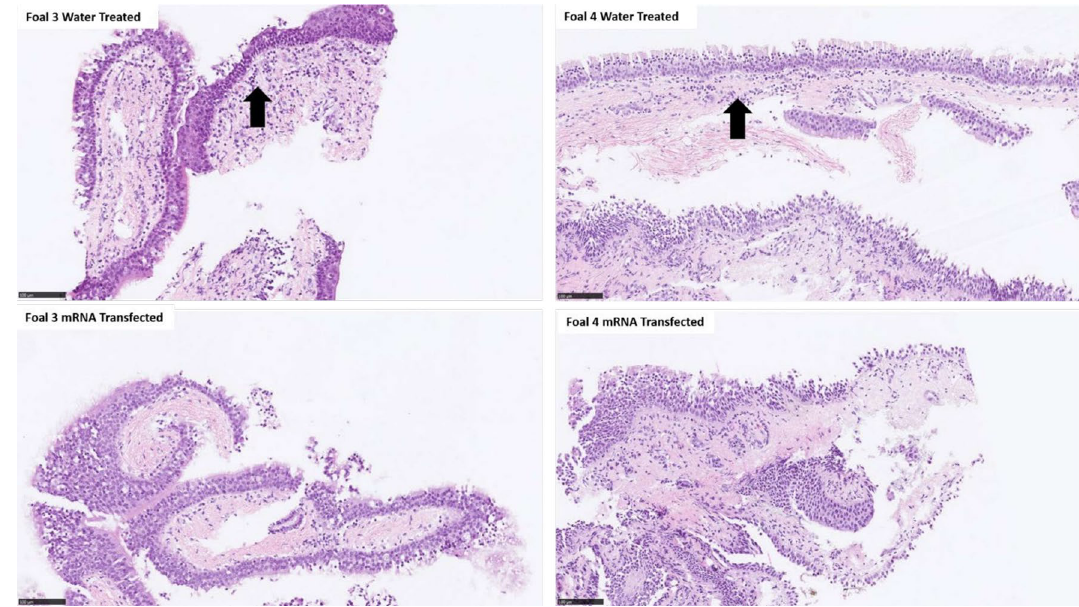
Figure 6. Transfection with eGFP did not result in microscopic evidence of inflammation. Minimal lymphocytic infiltration was present in the lamina propria of water-treated controls (arrows) from both foals but not in the mRNA-transfected tissues. Bronchial biopsies were obtained at 96 h from the water-treated and mRNA-transfected treated bronchial mucosa via transendoscopic smooth-mouthed biopsy instrument. Biopsies were fixed in 10% neutral phosphate-buffered formalin, embedded in paraffin, sectioned at 4 microns, and stained with hematoxylin and eosin. The scale bar is 100